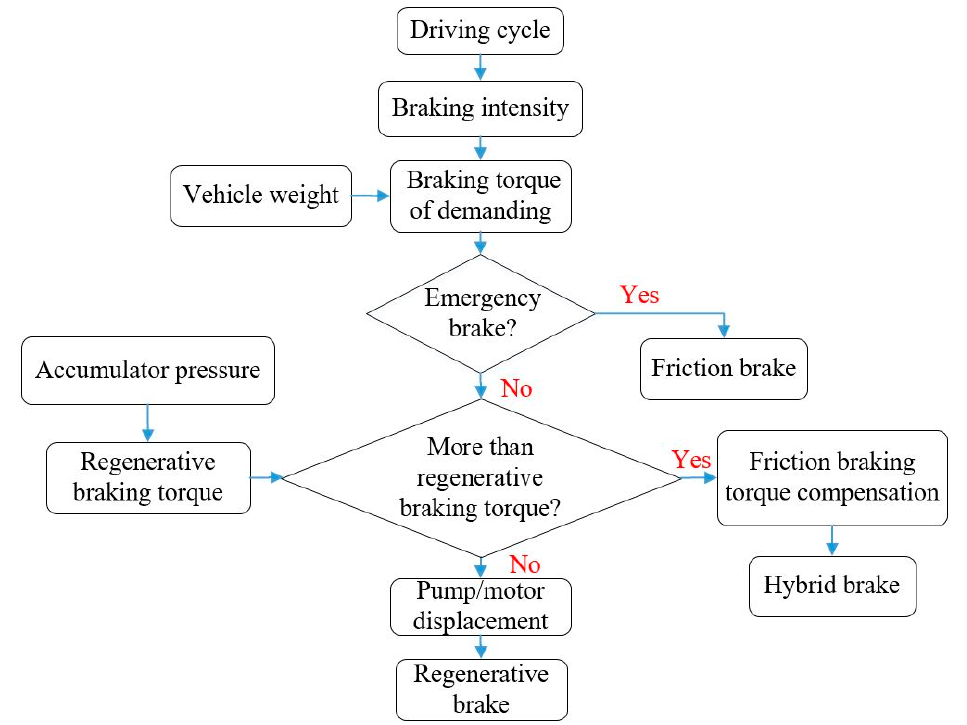
Figure 3. Flow chart of the critical energy control strategy.